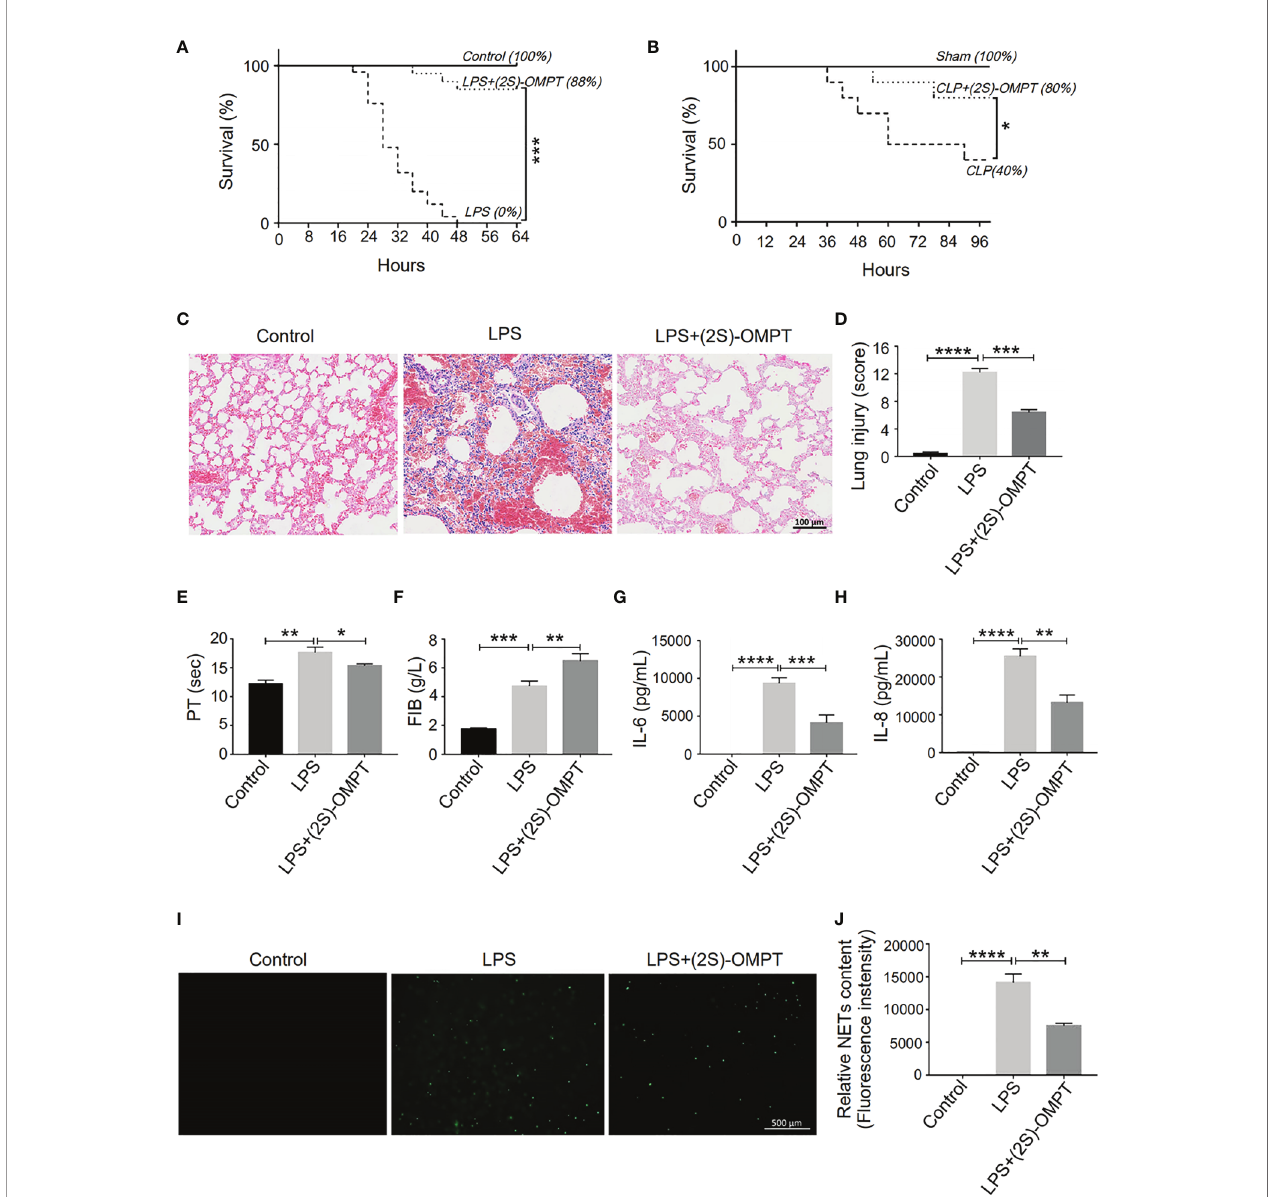
FIGURE 7 | LPA 3 agonist (2S)-OMPT possess potential therapeutic effect for sepsis. (A), The survival rate of LPS-induced septic mice with (2S)-OMPT. Mice were treated with (2S)-OMPT after LPS injection, monitored every 4 h for a 64-h period. (2S)-OMPT treatment improved the survival rate of mice with sepsis (control n = 6, LPS n = 16, LPS+(2S)-OMPT n = 16). (B), The survival rate of CLP-induced sepsis mice with (2S)-OMPT. Mice were treated with (2S)-OMPT after CLP, monitored every 6 h for a 96-h period. (Control n = 6, CLP n = 10, CLP+(2S)-OMPT n = 10) (C, D), H&E staining of the lungs of mice with sepsis with (2S)-OMPT. (2S)-OMPT treatment decreased lung injury of mice with sepsis (n = 5), Bar =100 m m. (E, F), The circulating levels of coagulation markers in the mice with sepsis with (2S)- OMPT. (2S)-OMPT treatment shortened PT, increased FIB levels, reduced the risk of thrombosis (control n = 6, LPS n = 7, LPS+(2S)-OMPT n = 7). (G, H), The plasma levels of the cytokines IL-6 and IL-8 in the mice with sepsis with (2S)-OMPT. (2S)-OMPT injection decreased the plasma content of IL-6 and IL-8 (n = 10). (I, J), SYTOX Green staining of NETs induced by the plasma from septic mice with (2S)-OMPT, (2S)-OMPT treatment decreased NETs formation of mice with sepsis (n = 8). *P < 0.05, **P < 0.01, ***P < 0.0001, ****P < 0.00001. LPA 3 , lysophosphatidic acid receptor 3; LPS, lipopolysaccharide; (2S)-OMPT; (2S)-1-oleoyl-2- methylglycero-3-phosphothionate; BSA, bovine serum albumin; PT, plasma prothrombin time; FIB, fi brinogen; NETs, neutrophil extracellular of MAPK (48). Lpar3 -/- female mice have delayed embryo implantation, embryo crowding, and reduced litter size (41). LPA 3 are also expressed in the testis (49, 50), suggesting a role for LPA 3 signaling in male sperm behavior and fertility.